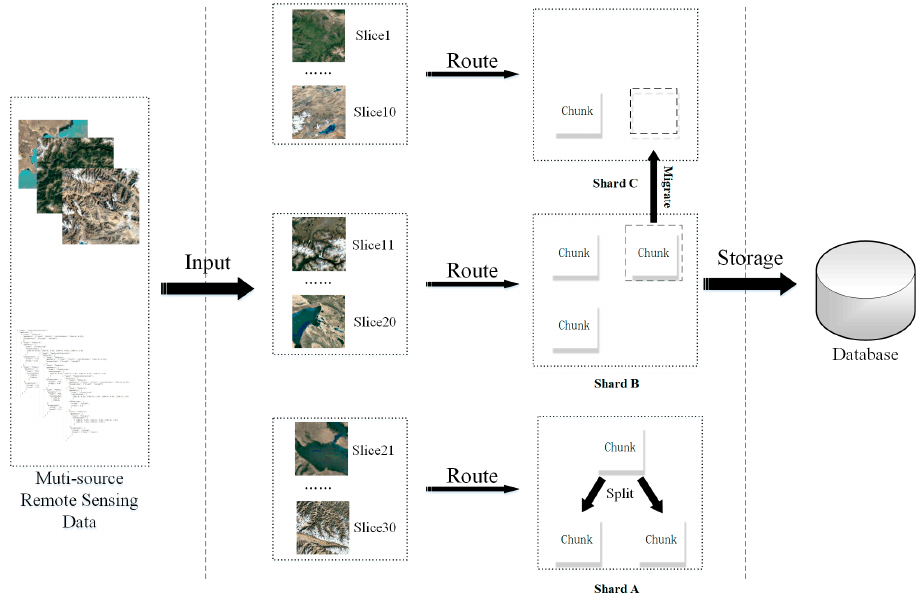
Figure 7. Remote sensing data distributed storage process.